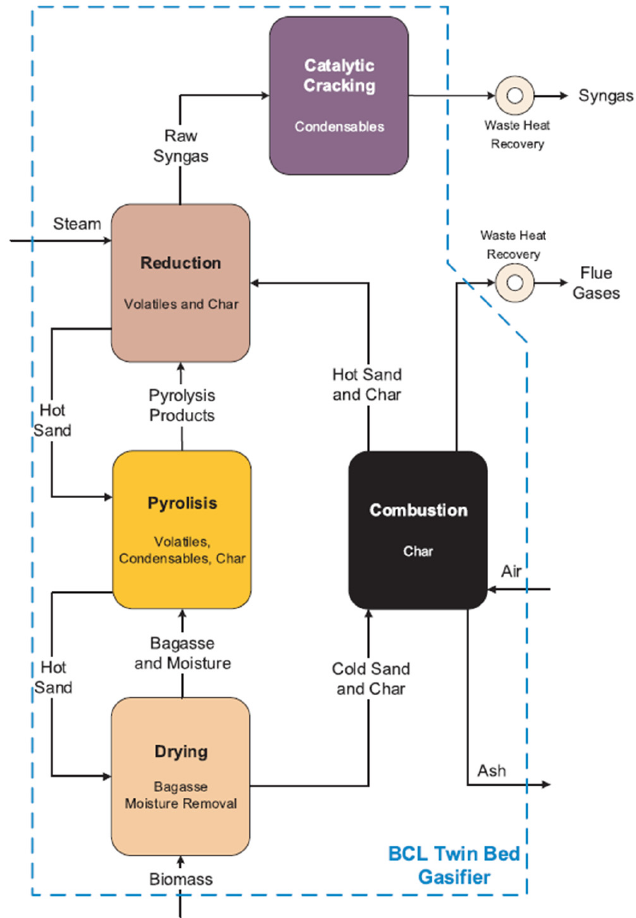
Figure 5. Modeling and simulation steps of the twin circulated bed BCL bagasse gasifier [60].